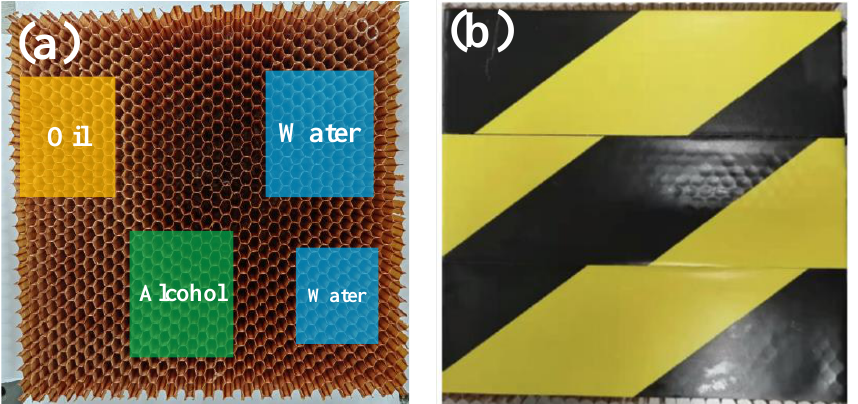
Figure 4. Pictures of the GFRP honeycomb sandwich structure with liquid ingress ( a ) before and ( b ) after the top surface skin is mounted and sealed.